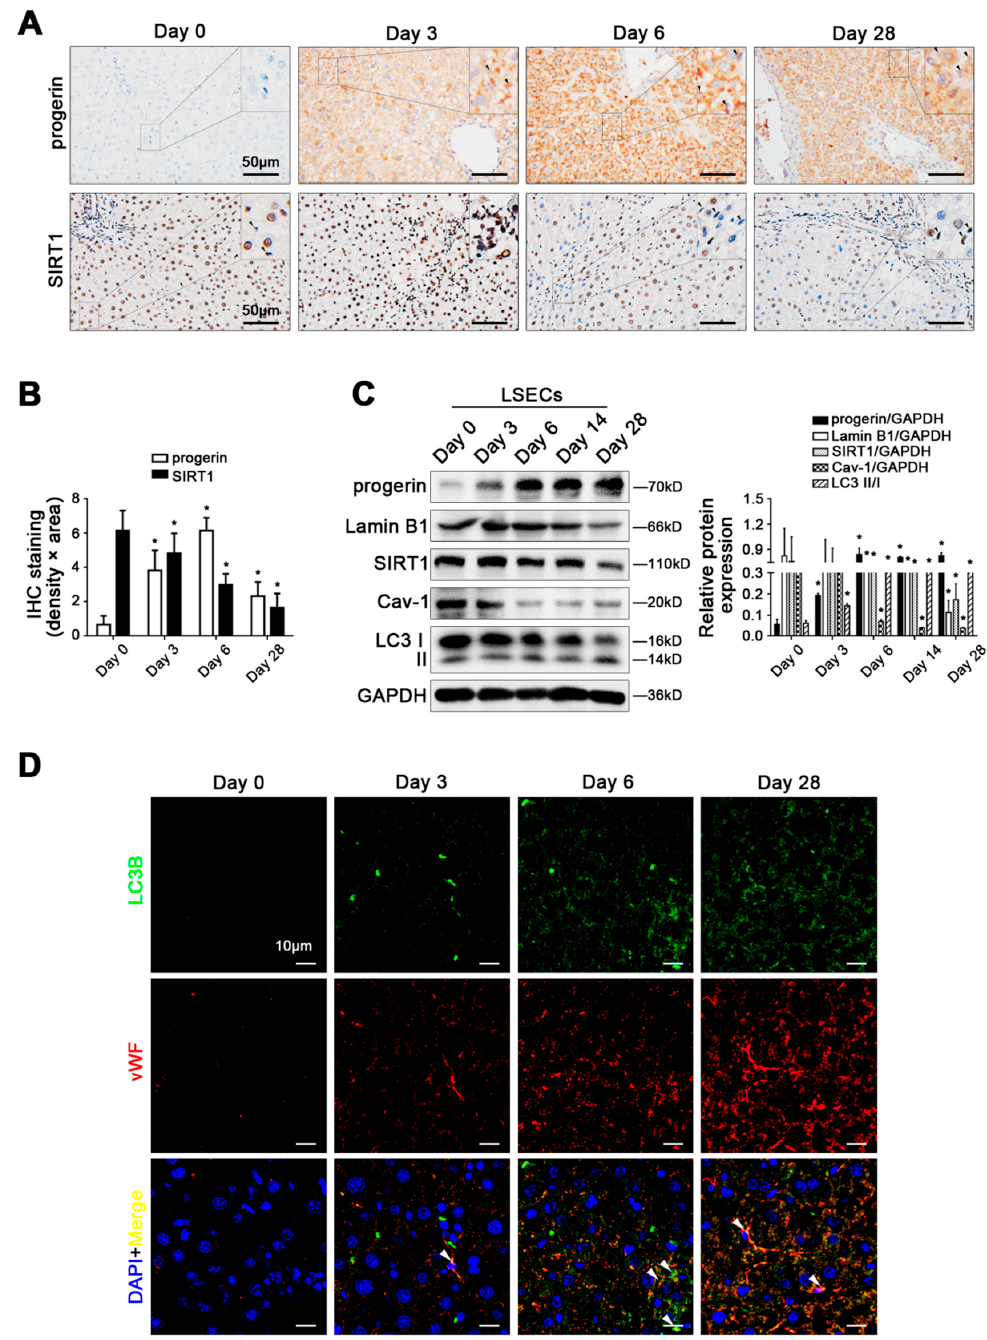
Figure 2. Abnormal accumulation of progerin and Cav-1-related autophagy emerge in defenestrated and capillarized hepatic sinusoidal endothelium, along with loss of SIRT1. ( A ) IHC staining of progerin and SIRT1 in liver tissue of CCl 4 -induced rat models at different time points (day 0, day 3, day 6, and day 28) (scale bar: 50 µ m). The black triangles indicate progerin- and SIRT1-positive LSECs. ( B ) The semi-quantified analysis for the area density of IHC staining of progerin and SIRT1 in the graph. * p < 0.05 versus the day 0 group. ( C ) Representative immunoblots of progerin, Lamin B1, SIRT1, Cav-1, and LC3 II/I in primary LSECs, which were isolated from CCl 4 -induced rat models at different time points (day 0, day 3, day 6, day 14, and day 28). The relative protein expression was quantified in the graph (right). * p < 0.05 versus the day 0 group. ( D ) The co-localization of LC3B (green) with vWF (red) in liver tissue of CCl 4 -induced rat models at different time points (day 0, day 3, day 6, and day 28) (scale bar: 10 µ m). Nuclei are shown by DAPI (blue). N = 6 per